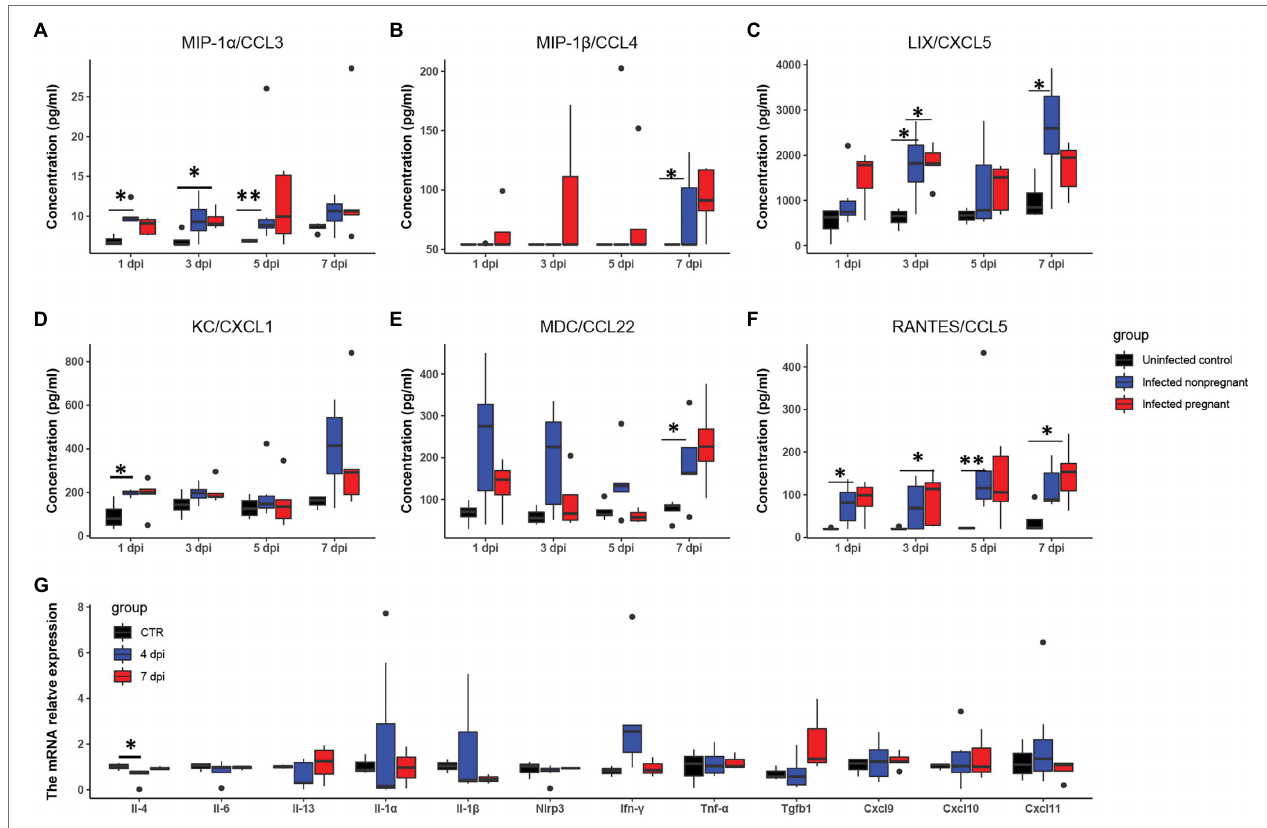
FIGURE 4 | The feature of proinflammatory cytokines. The concentrations of “cytokine storm” related chemokines in plasma were measured. (A–F) Showed the changes of six chemokines ( n ≥ 3 per each group). (A) MIP-1 α /CCL3. (B) MIP-1 β /CCL4. (C) LIX/CXCL5. (D) KC/CXCL1. (E) MDC/CCL22. (F) RANTES/CCL5. (G) The changes of pro-inflammatory cytokines in the uterus of infected non-pregnant mice. * p < 0.05. ** p <